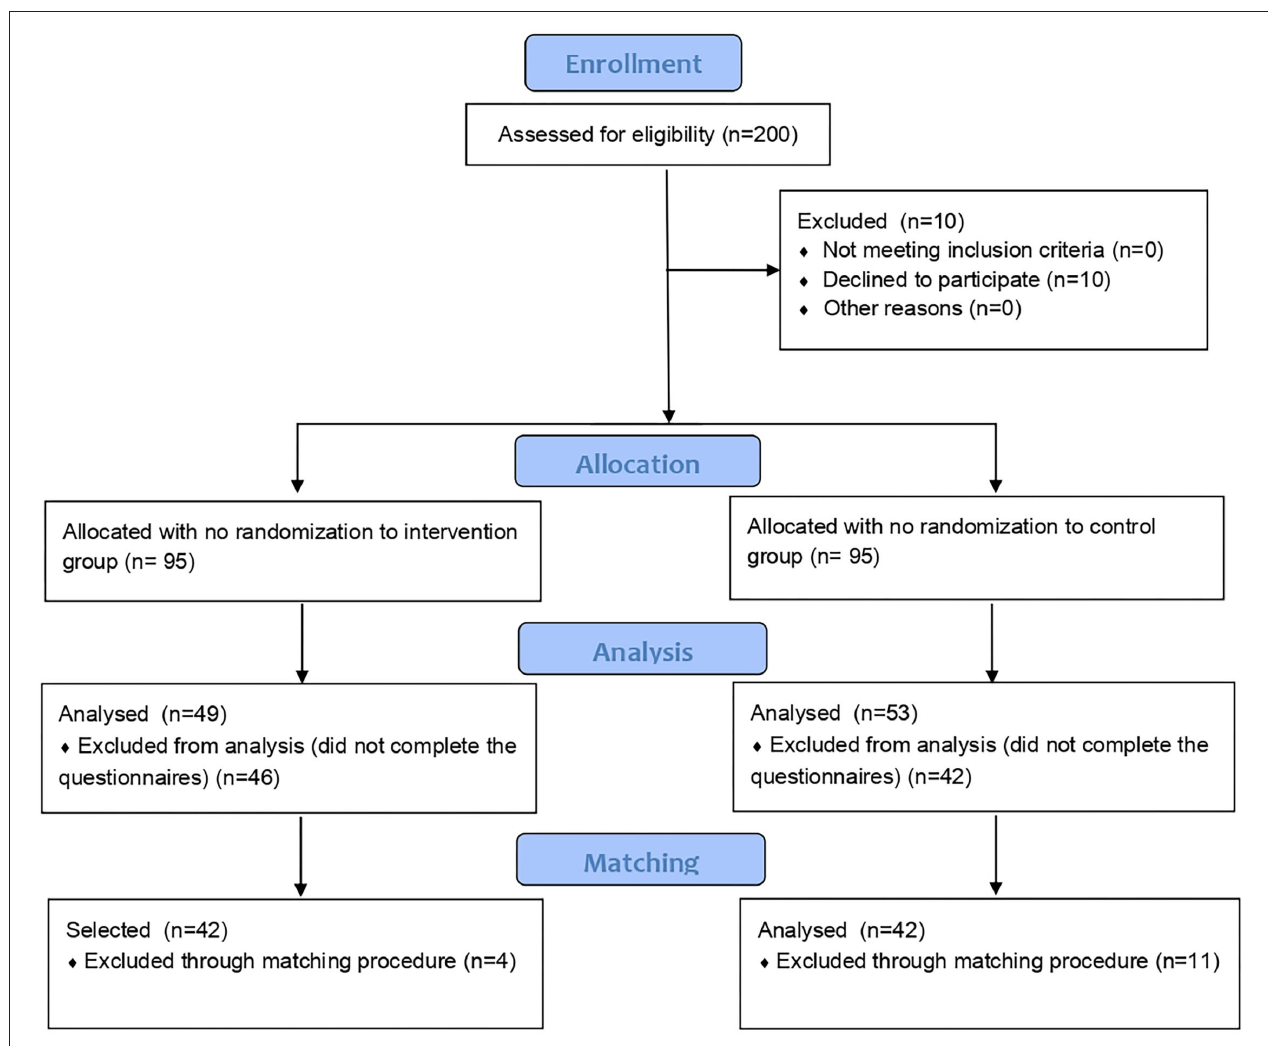
FIGURE 2 | Histogram of the density of propensity score distribution in the two groups, i.e., treated and control, before (Raw) and after the matching procedure